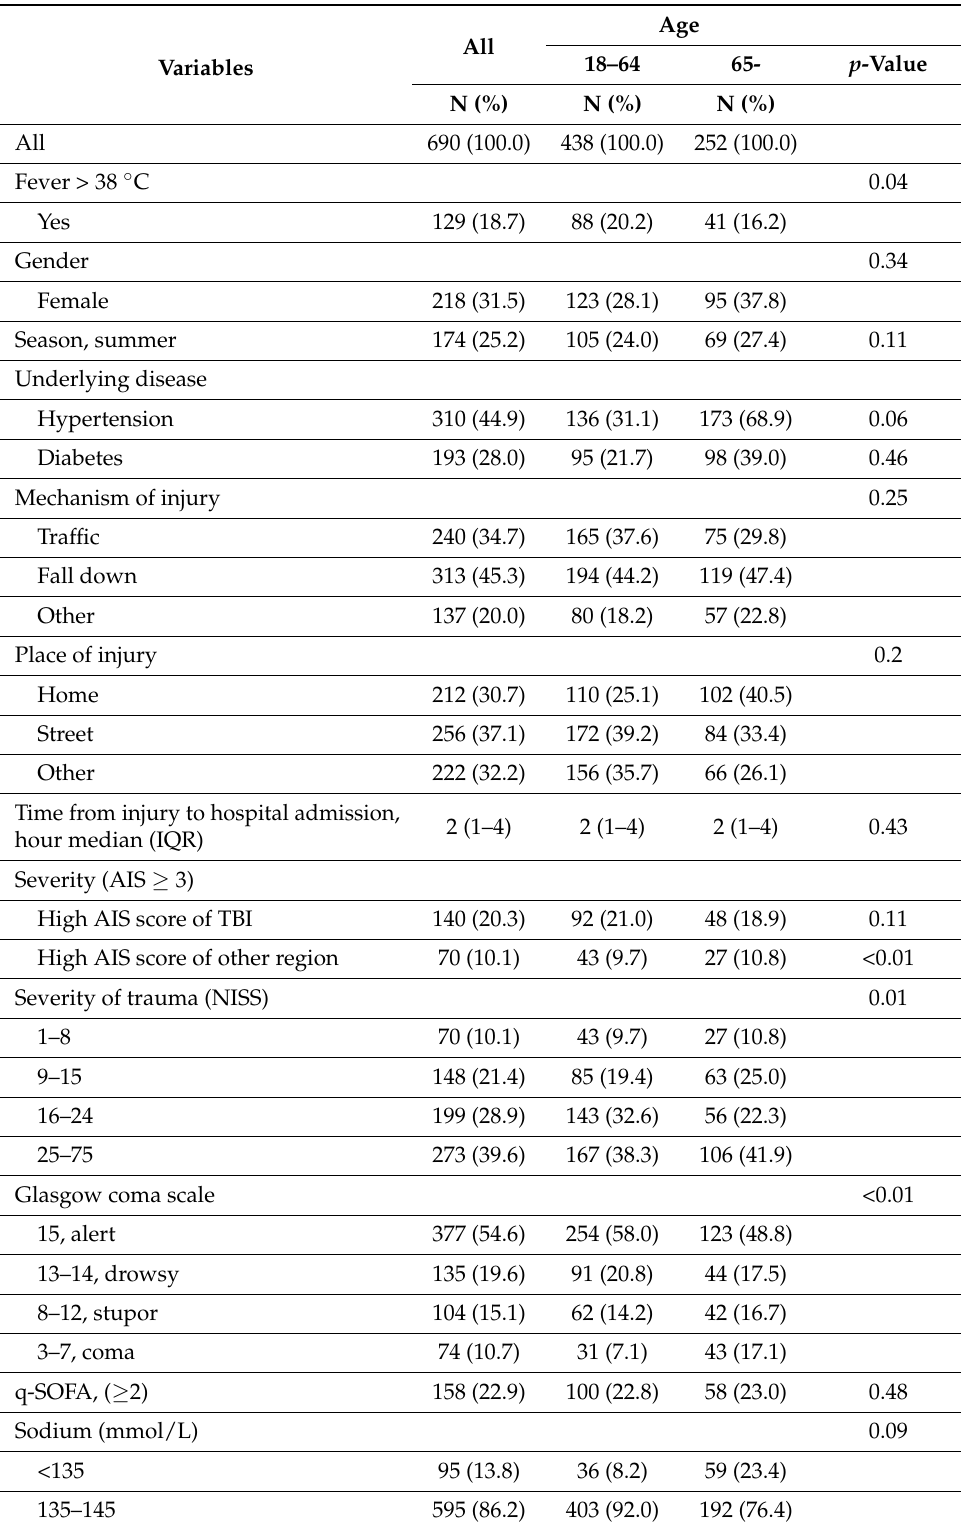
Table 2. Characteristics and clinical outcomes between traumatic brain injury patients according to